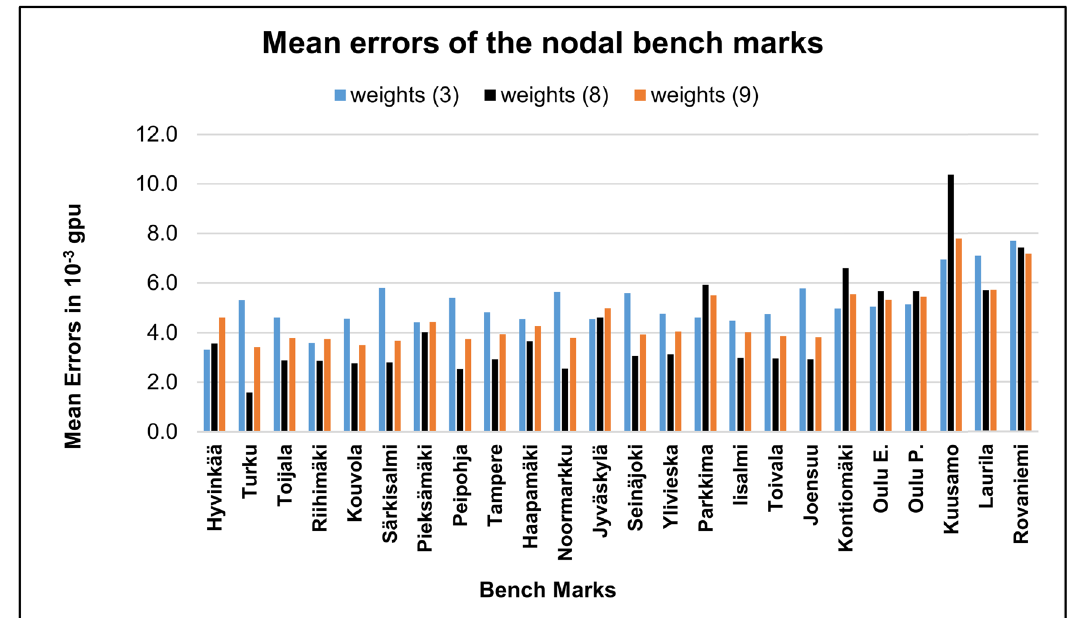
Figure 4: Mean errors of the nodal benchmarks derived from the adjustments with weights ( 3 ) – P L 1 = / , weights ( 8 ) – P weights ( 9 ) – P H 1 = /| |